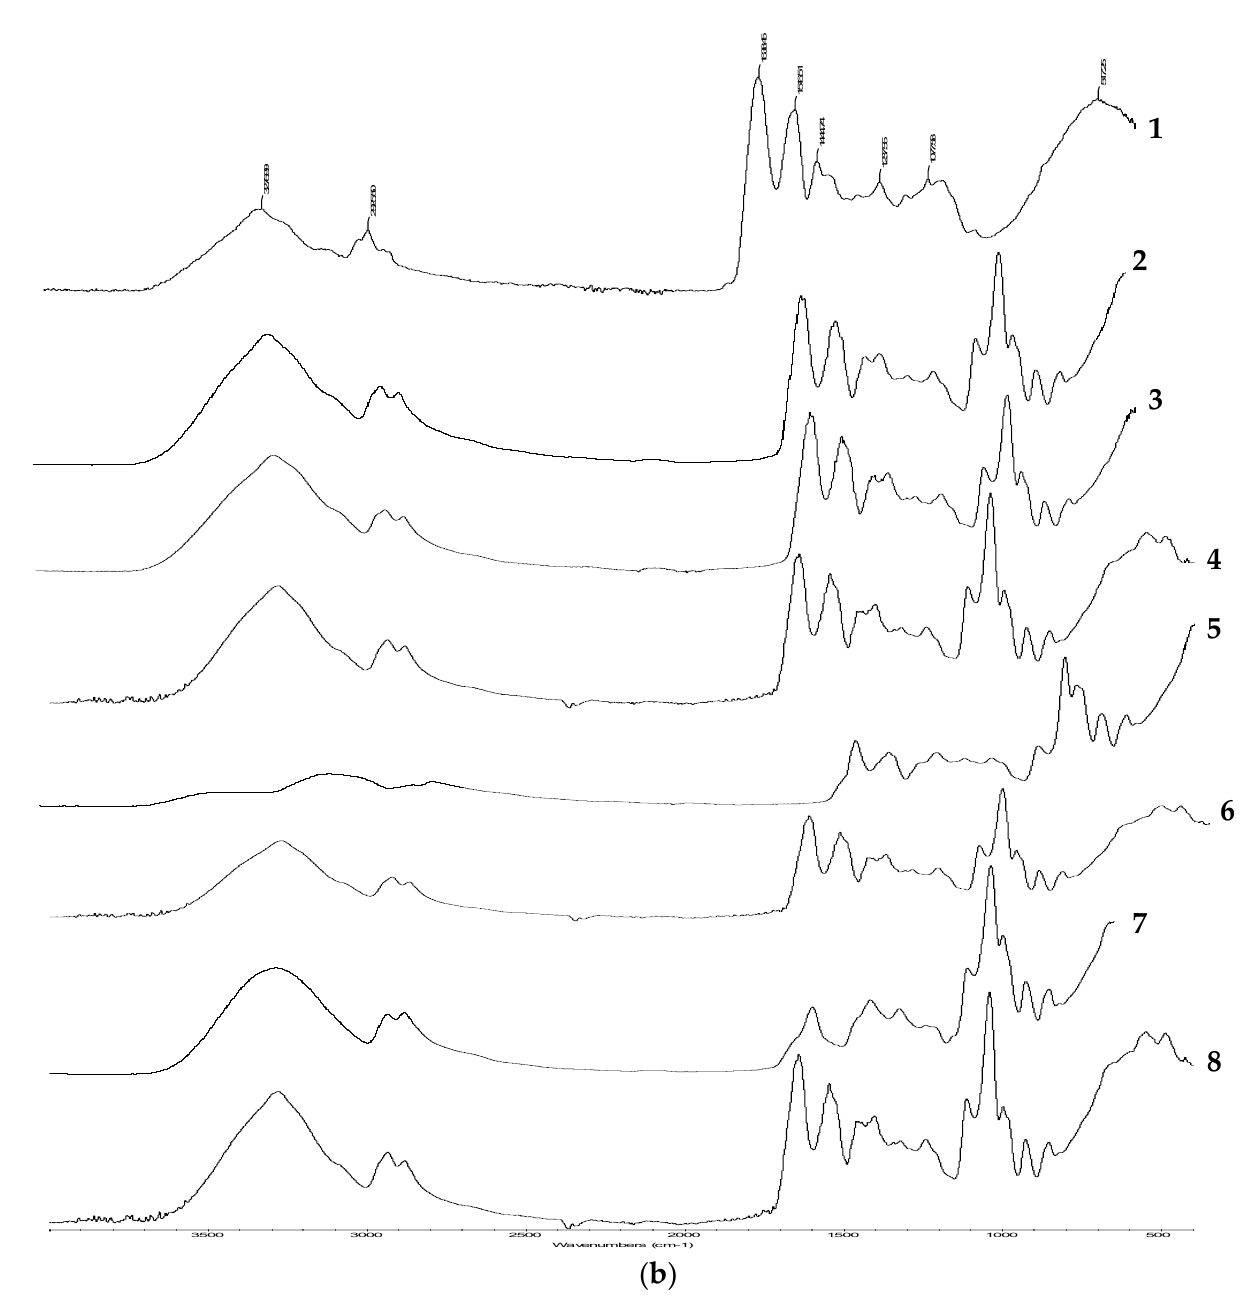
Figure 6. ( a ) FTIR spectra of edible film samples with and without transglutaminase (1) TGase powder, (2) CMCH 100, (3) NaCA 100, (4) NaCA 75, (5) NaCA 75-TGase, (6) NaCA 50, (7) NaCA 50-TGase, (8), NaCA 25, and (9) NaCA 25-TGase [CHCH = carboxymethyl chitosan; NaCA = sodium caseinate, CaCA = calcium caseinate, 100, 75, 50, and 25 represent the proportion of the individual component, the balance out of 100 being CMCH]. ( b ) FTIR spectra of edible film samples with and without transglutaminase (1) TGase powder, (2) CaCA 100, (3) CaCA 75, (4) CaCA 75-TGase, (5) CaCA 50, (6) CaCA 50-TGase, (7), CaCA 25, and (8) CaCA 25-TGase [CHCH = carboxymethyl chitosan; NaCA = sodium caseinate, CaCA = calcium caseinate, 100, 75, 50, and 25 represent the proportion of the individual component, the balance out of 100 being CMCH].